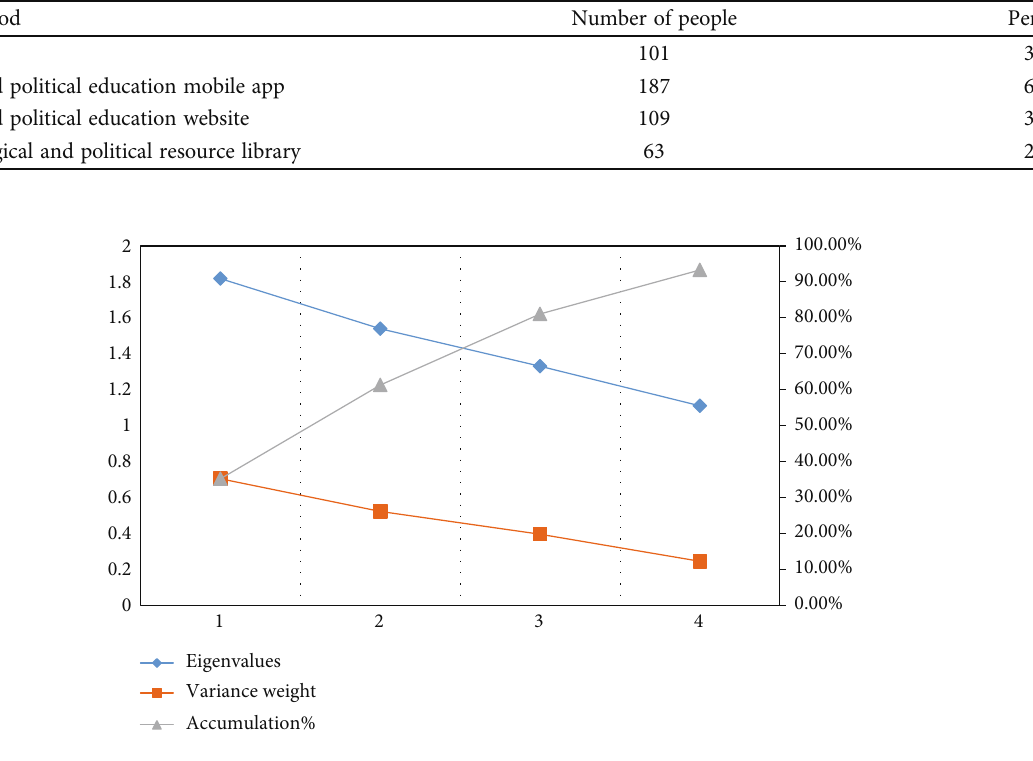
Figure 6: The proportion of variance in the thought and moral quality components of university students.